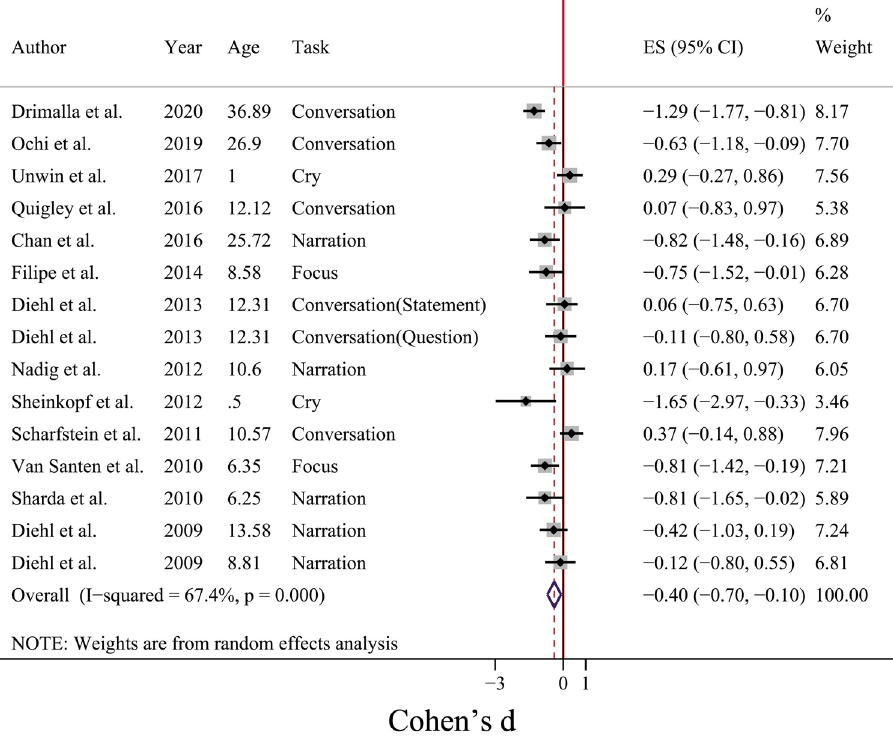
Figure 2. Forest plot for mean pitch value measure. The negative sign shows that the mean pitch value is larger for ASD individuals as compared with TD individuals.